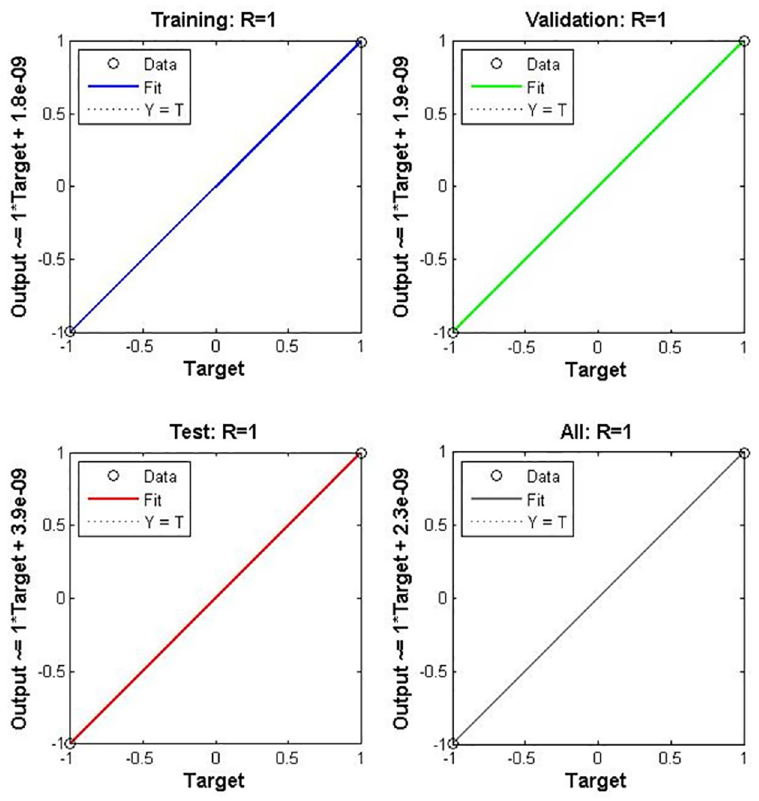
Fig 10. Training status of